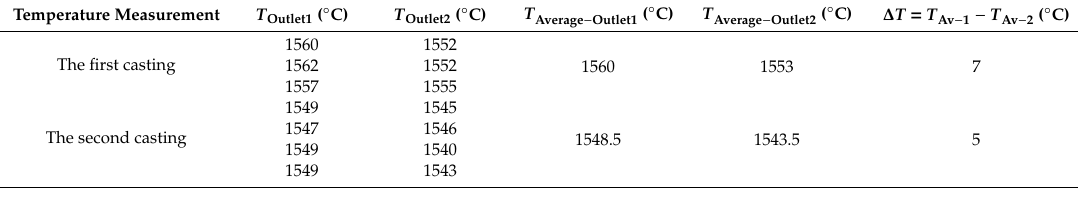
Table 7. The measured temperature of molten steel at di ff erent outlets in the optimized tundish. Temperature Measurement